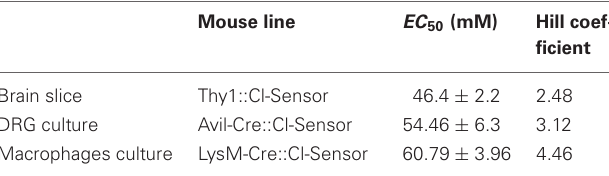
described in the manuscript.